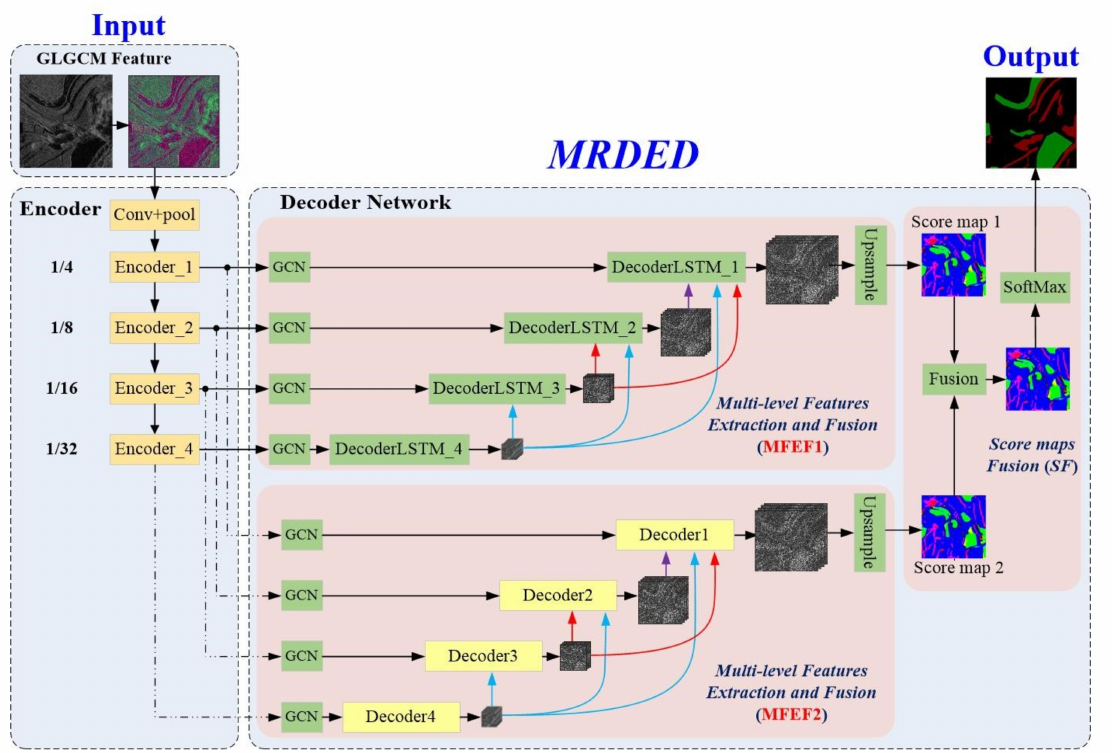
Figure 2. The overall architecture of the proposed network. MRDED denotes Multi-resolution Dense Encoder and Decoder framework, which contains GLGCM feature, Encoder network and Decoder network. The input is SAR images, and the output is the final extracted results of water and